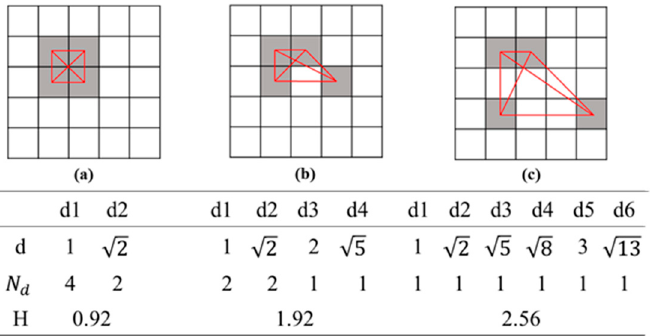
Figure 5. Pixel intra-class distance and its entropy calculation. Six line segments with (a) two cases of line distance, (b) four cases of line distance, and (c) six cases of line distance.